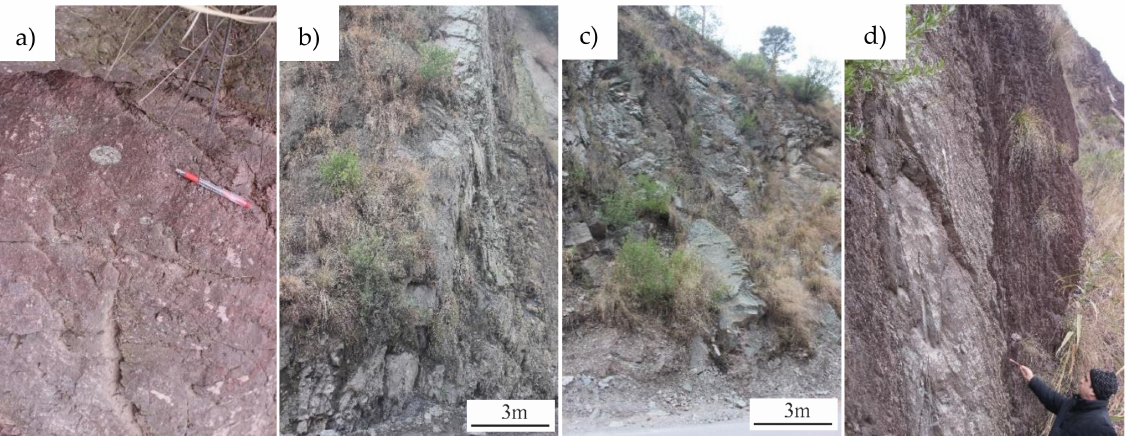
Figure 4. Photomicrograph showing ( a , b ) Dolomitic mudstone bed, ( c ) coarse-grained sandstone bed, and ( d ) erosional upper contact with the Murree